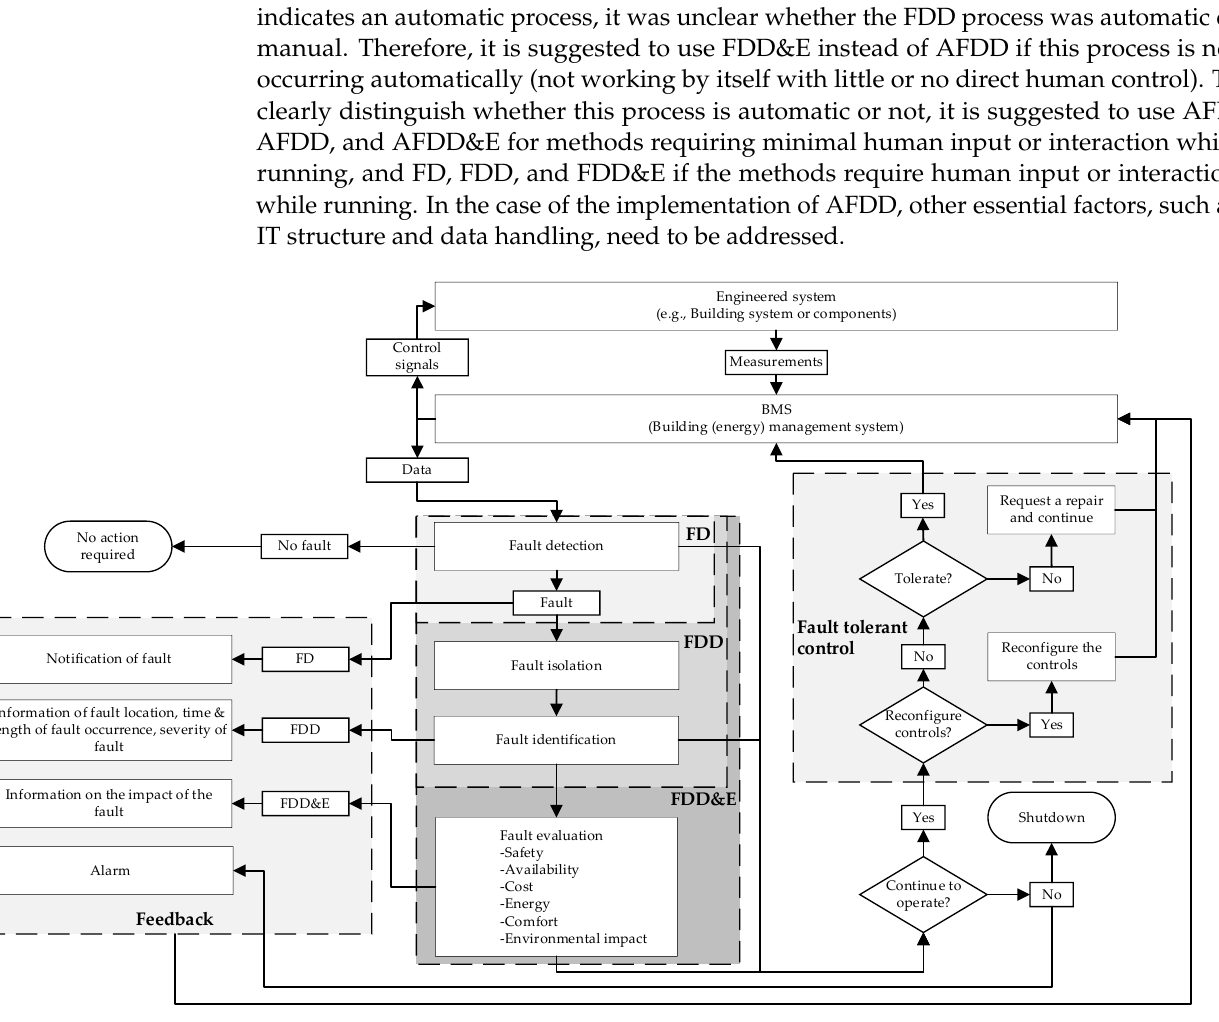
Table 4. Categorization of methods in selected articles used to streamline the categorizations found in the explored literature. The mentioned references below created categorizations in their review. Ref.